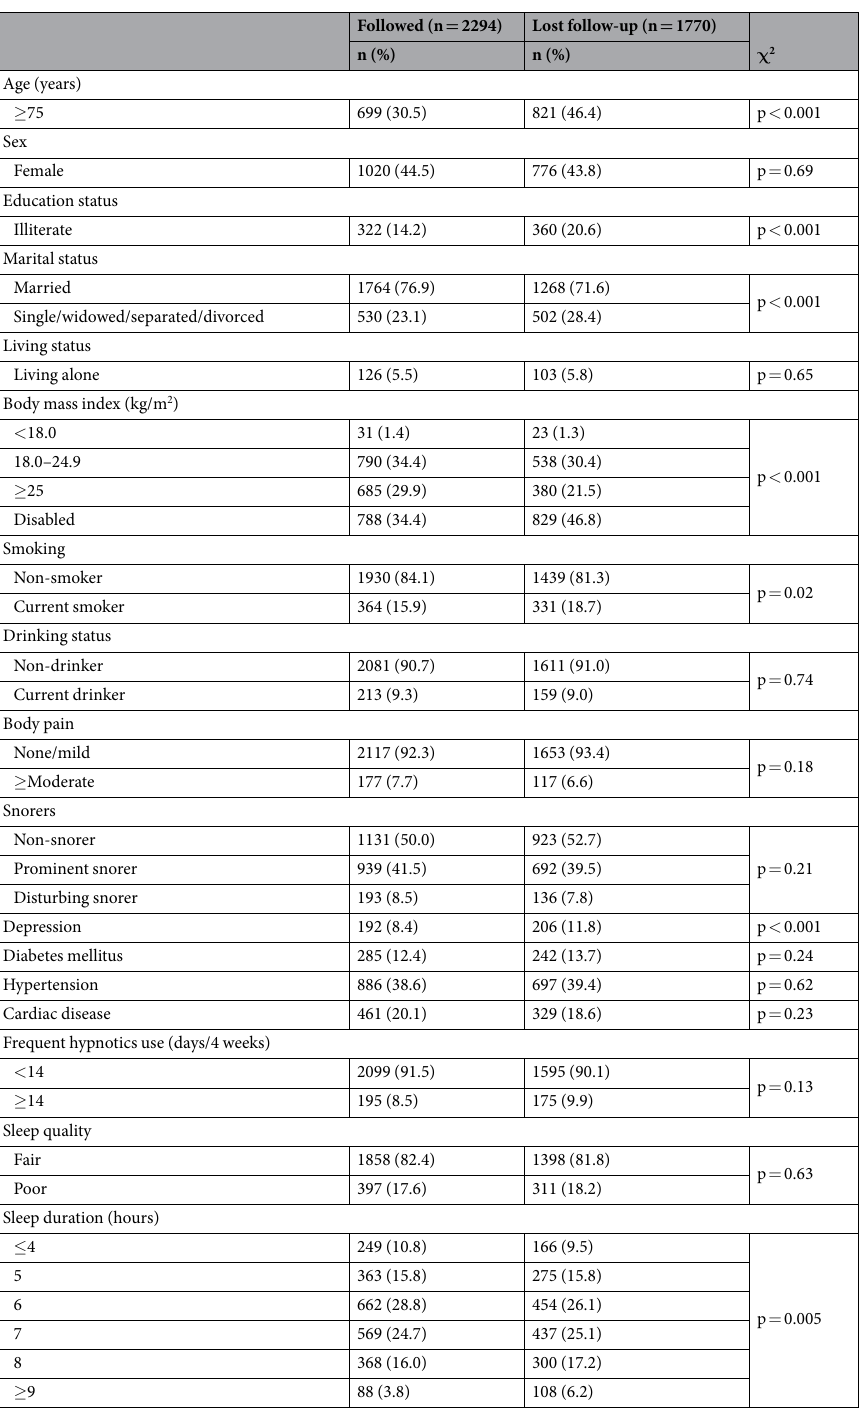
Table 1. Comparison of baseline characteristics by follow-up status of participants (n = 4064) * . * Numbers of subjects are not equal to subtotals in each category due to missing values of